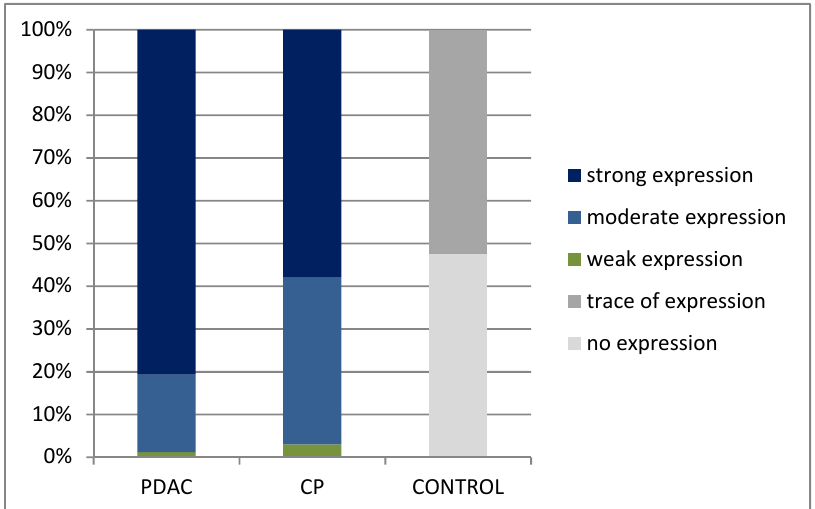
Figure 3. Comparison of intensity of α SMA immunoexpression in pancreatic ductal adenocarcinoma (PDAC), chronic pancreatitis (CP) and in healthy tissue (CONTROL).